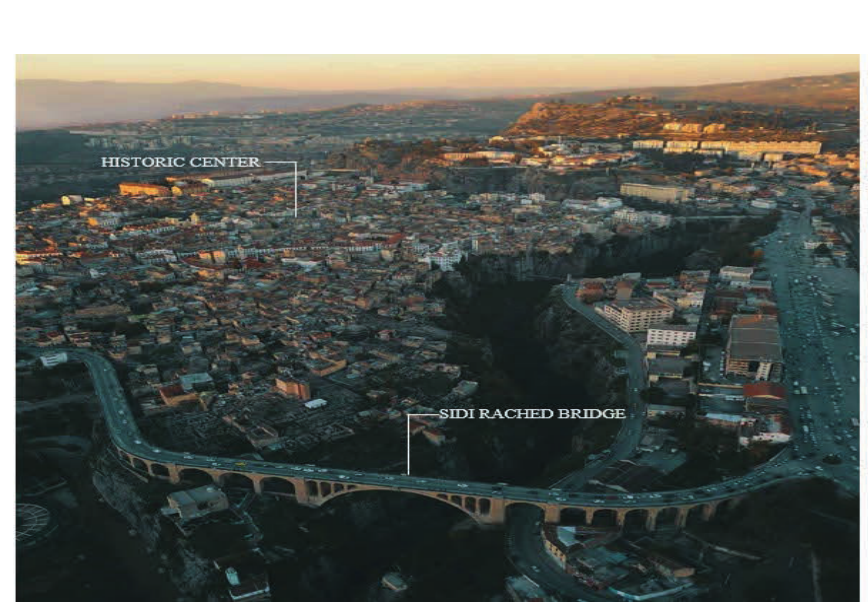
Fig. 4. The historic centre which juxtaposes the Bardo Park (Google 2021, authors’ treatment).